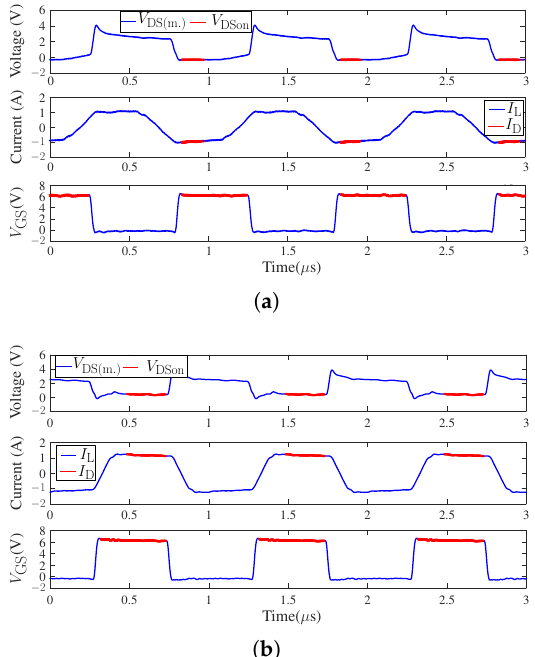
Figure 14. GaN-HEMT dynamic R DSon measurement results by proposed TZCM when device switches at 1 MHz: ( a ) R B DSon and ( b ) R E DSon